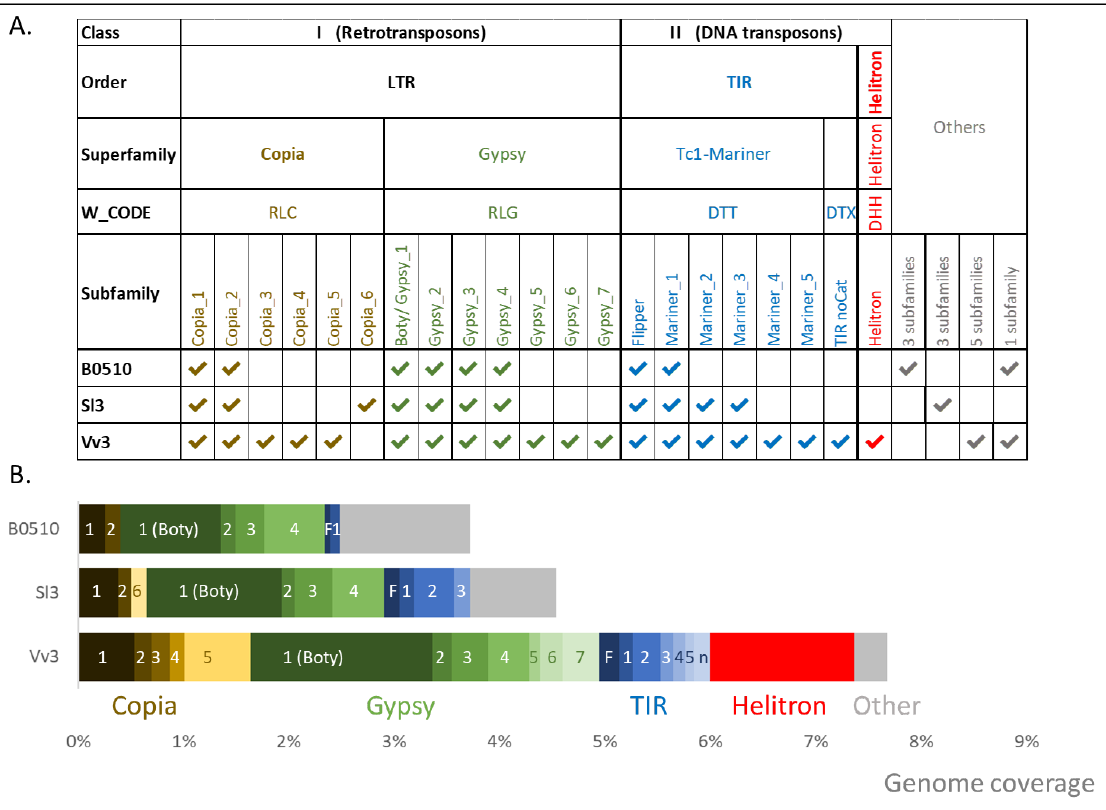
Figure 2: Transposable Elements (TEs) in the genomes of the B. cinerea strains B05.10, Sl3 and Vv3. A. Subfamilies of TEs identified in the Sl3 and Vv3 strains were classified according to Wicker et al., (2007), as previously done for the strain B05.10 (Porquier et al., 2016). In the present study, all Boty consensus were merged into a single subfamily. B. Total genome coverage was detailed for the different subfamilies. For more details, see Sup. Table